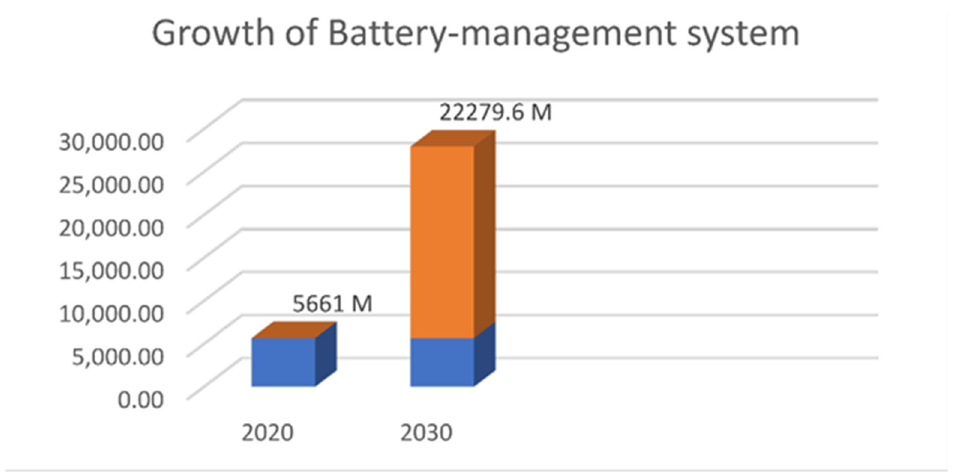
Figure 5. Growth of Battery-management systems from 2020 to 2030 [54].